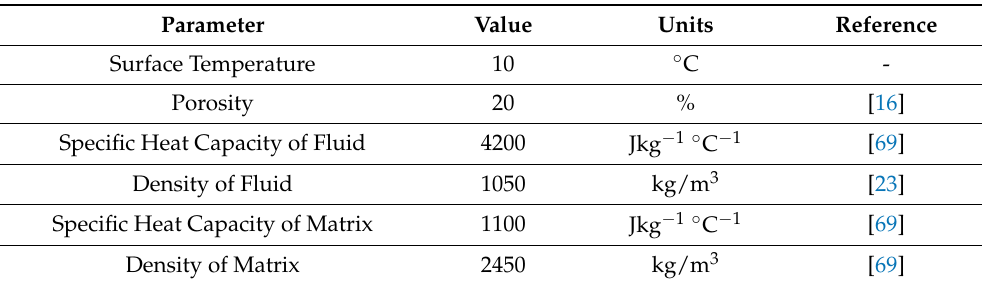
Table 4. Parameter input for quasi-3D geothermal resource calculation. Sources of data input were obtained from Brown et al. [69], Jackson [16], Plant et al. [23]. Parameter